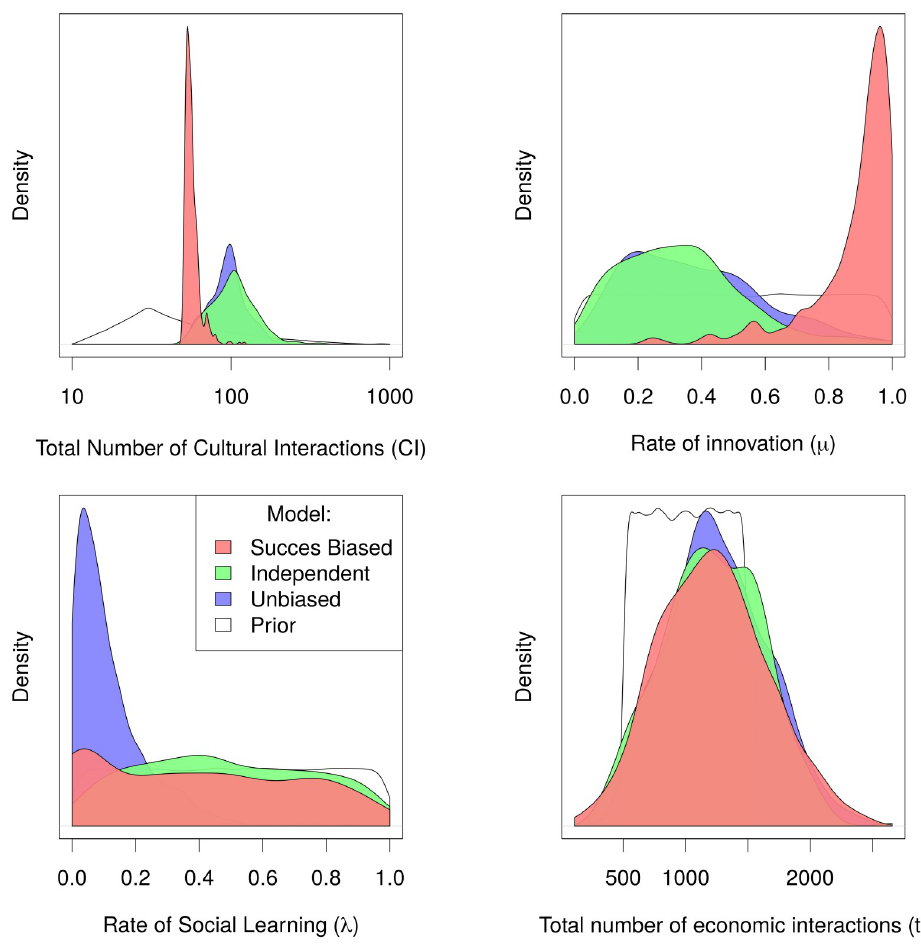
Fig 5. Posterior distributions for the three models. Posterior distributions of parameters drawn using the 500 accepted simulations from the last ABC step ( � = 0.0099).